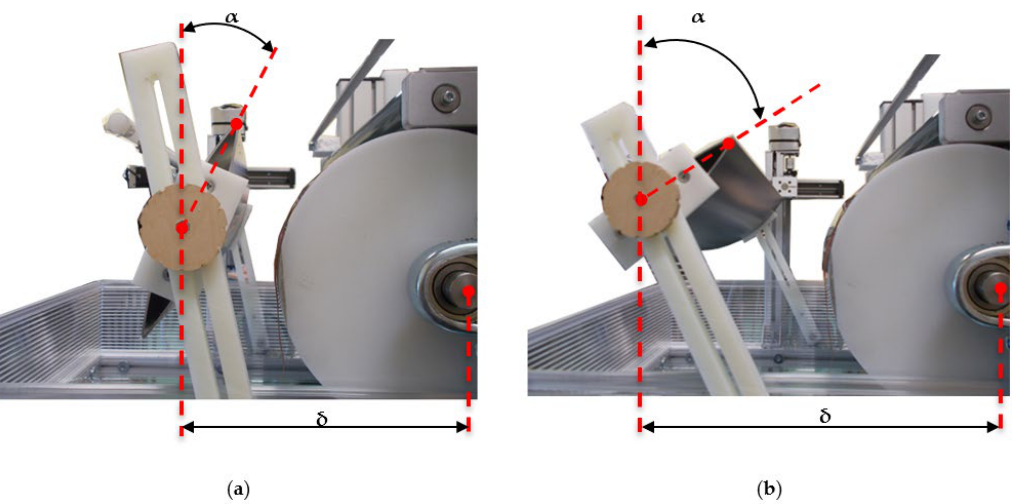
Figure 6. Considered positions of the deflecting electrode: position I ( a ) α = 13°, δ = 150 mm andposition II ( b ) α = 48°, δ = 210 mm.